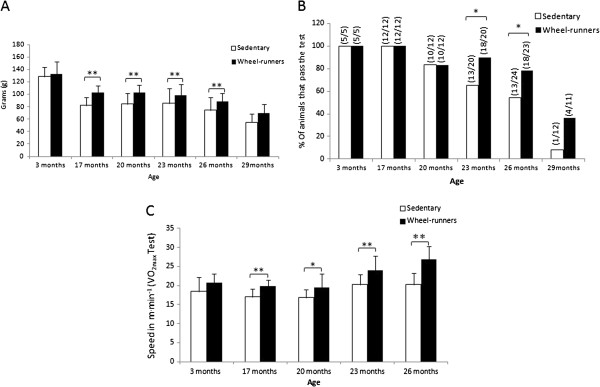
Functional tests performed at different survival time points (3, 17, 20, 23, 26 and 29 months old) in the longevity curve. A) shows the mouse grip strength values in grams. All the available animals were tested at the different ages. B) shows motor coordination. It was determined as the percentage of animals that successfully passed the tightrope test. The fraction of mice passing the test is indicated above the bars. The number of animals tested (n = 12 to 24) varied at the different ages. C) shows the maximal running speed achieved in a VO2max test and that was considered the maximal aerobic workload capacity of the animal (n = 20). Values are shown as mean ± SD. (*) indicates P <0.05, (**) indicates P <0.01 versus the sedentary group at the different ages. Continuous lines show statistically significant differences between the sedentary and the wheel-running groups. VO2max, exercise capacity.